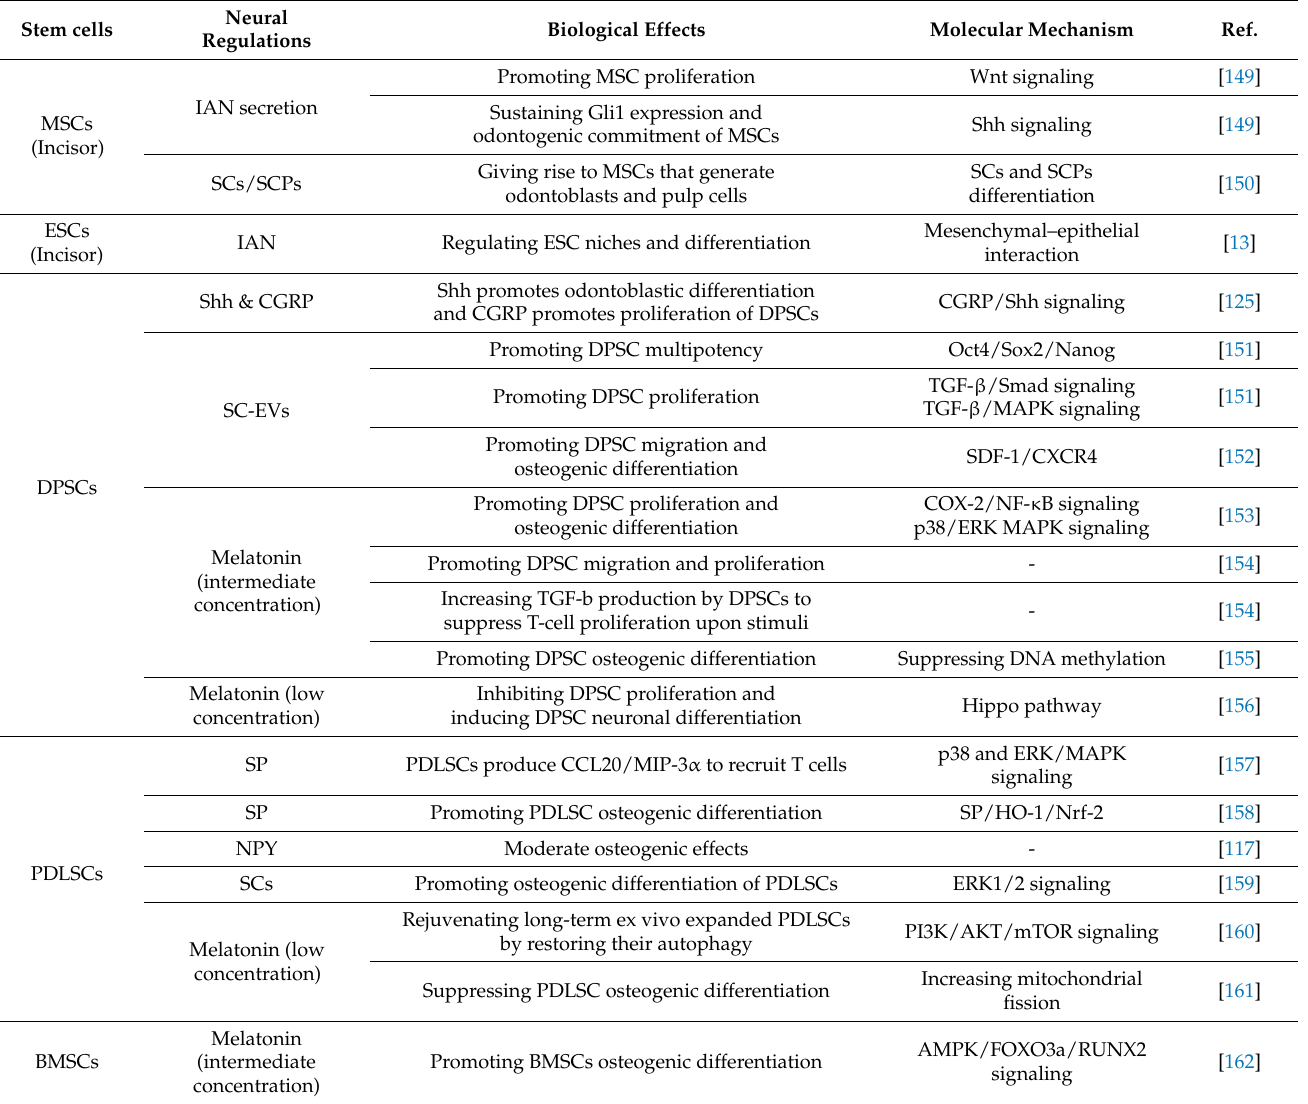
Table 3. The stem cells related to the tooth–periodontium complex are regulated by the nervous